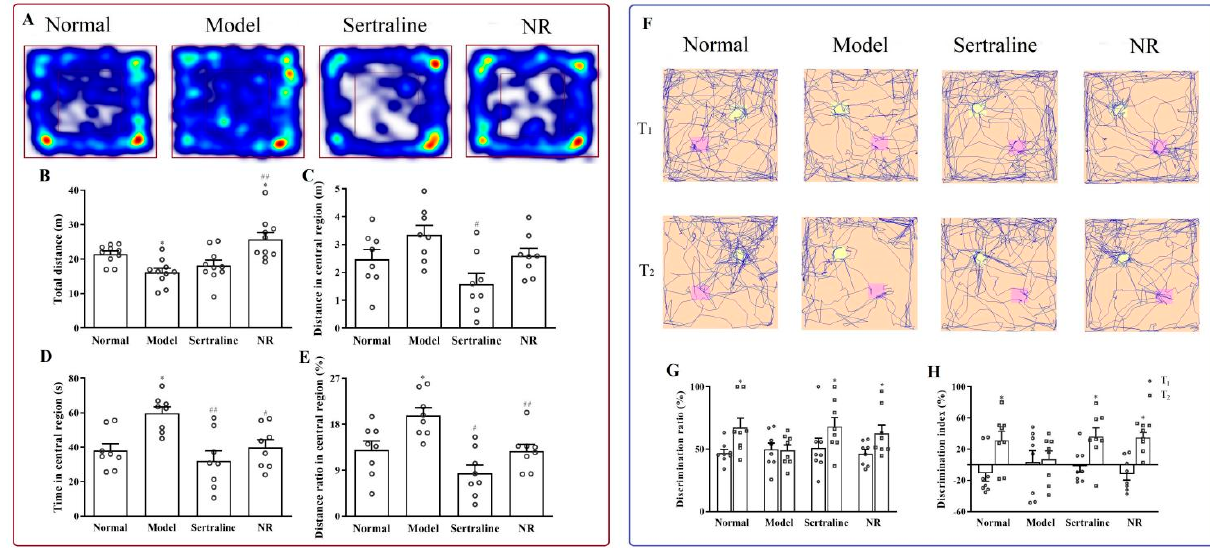
Figure 8. Improvement of locomotor activity and the cognitive function with NR treatment in rats. ( A ) Heatmap and typical tracks in OFT. ( B ) Distance traveled overall in OFT. ( C ) Distance covered in the central region. ( D ) Time spent in the center region. ( E ) Distance ratio in the center region. ( F ) Typical tracks in NORT. ( G ) DR in NORT. ( H ) DI in NORT. * p < 0.05 vs normal group; # p < 0.05, ## p < 0.01 vs. model group in Figure 8B − E. Data in Figure 8G,H were analyzed using t -tests. * p < 0.05 vs. T 1 in DR (Figure 8G) and in DI (Figure 8H).